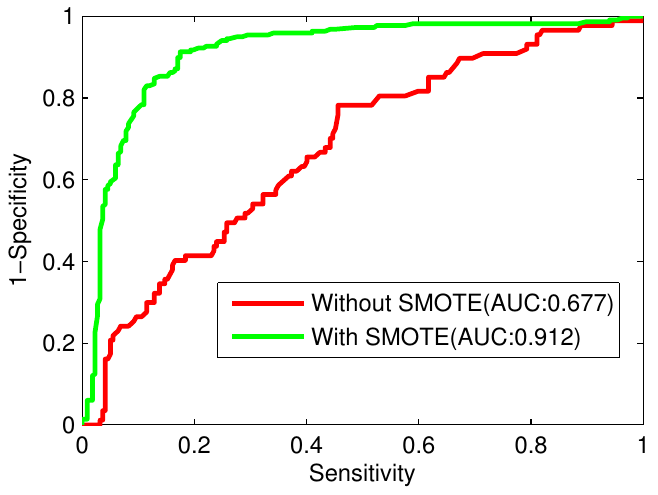
Figure 4. ROC (Receiver-Operating Characteristic) curves with and without